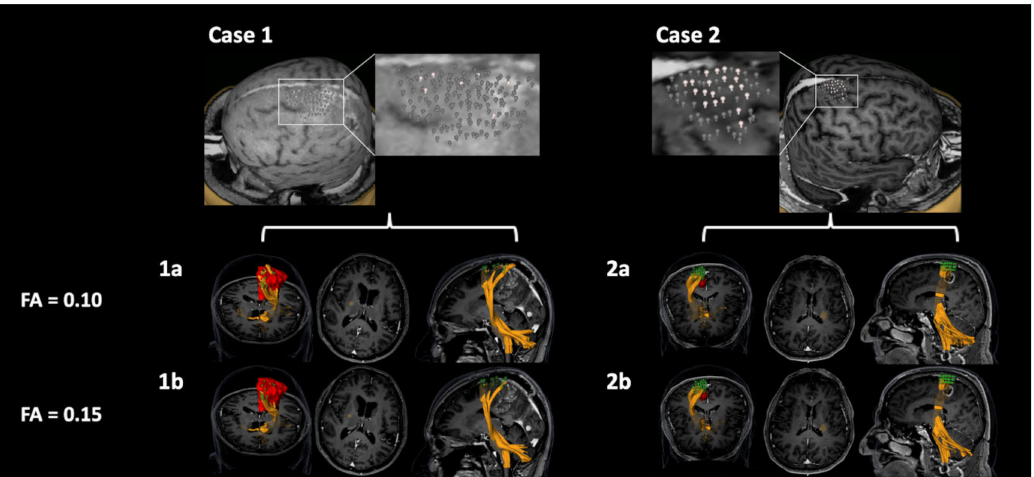
Figure 6. Patient cases with motor maps derived from paired-pulse navigated transcranial magnetic stimulation (pp-nTMS) only. This figure depicts two example patient cases ( 1 and 2 ) in whom pp-nTMS motor mapping yielded a motor map whilst single-pulse nTMS (sp-nTMS) failed. The motor map and corresponding di ff usion tensor imaging fiber tracking (DTI FT) of the CST is shown, using a fractional anisotropy (FA) of 0.1 ( a ) and 0.15 ( b ) for tractography. Motor maps are shown in red or green, the CST is depicted in